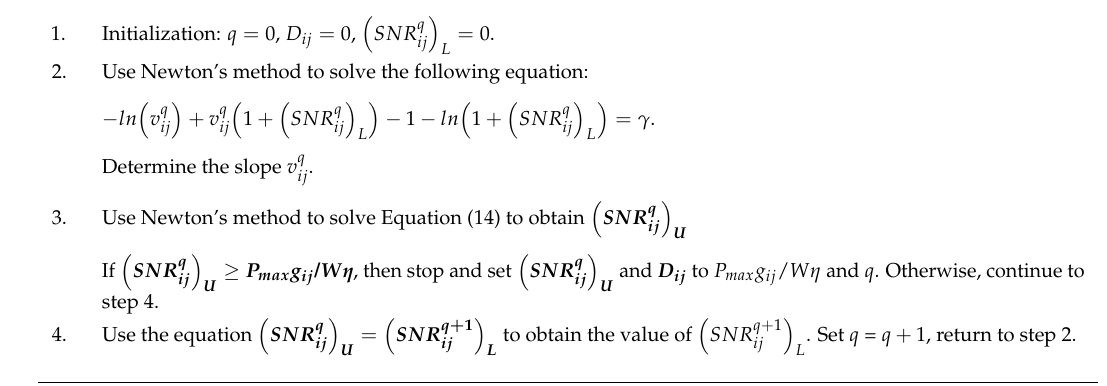
Algorithm 1: Piece-wise Linear Method